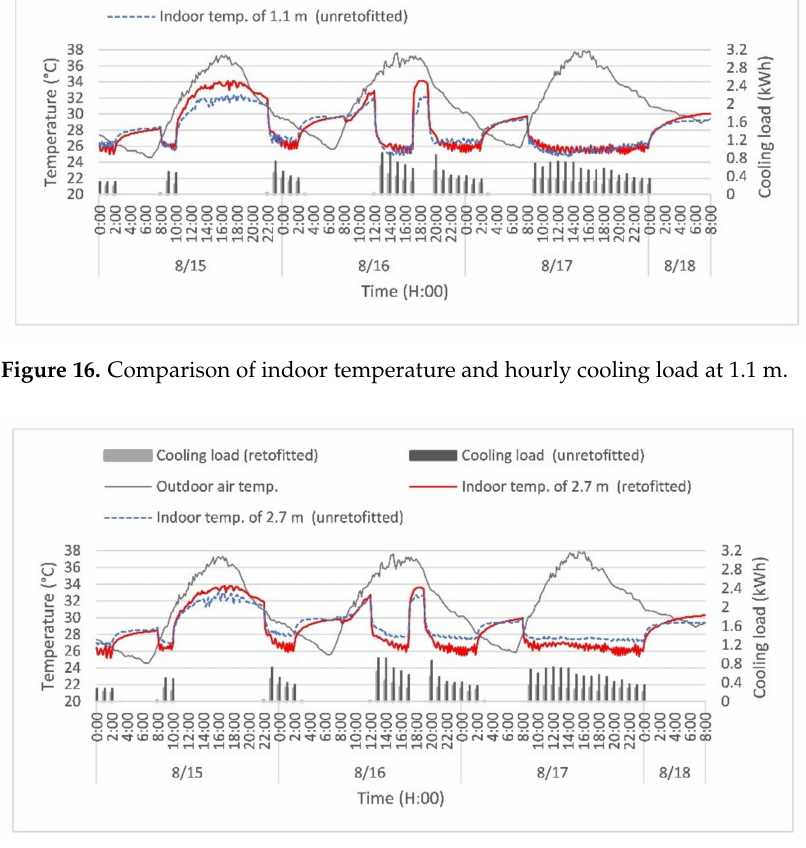
Figure 17. Comparison of indoor temperature and hourly cooling load at 2.7